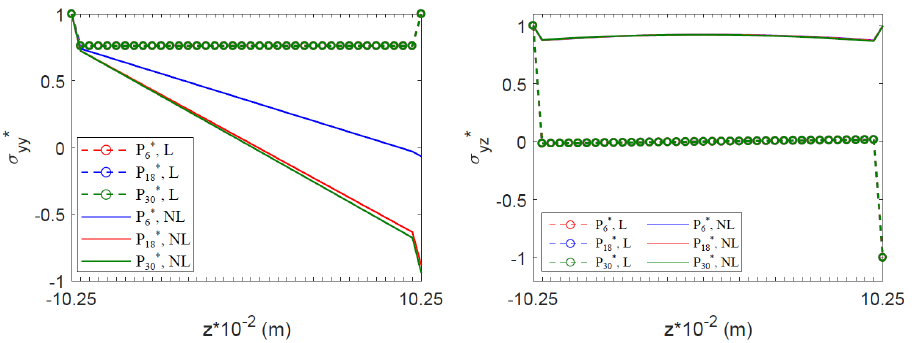
Figure 24. Distribution of axial and shear stress components for P ∗ = − 0.115, P ∗ = − 0.141, and P ∗ = − 0.1477 values in L9 extensions at x = − a 2 /2 and y = L /2 in the two-cell FG beam subjected to axial loading for m = 0.5, ( σ ∗ yy = σ yy / σ yy